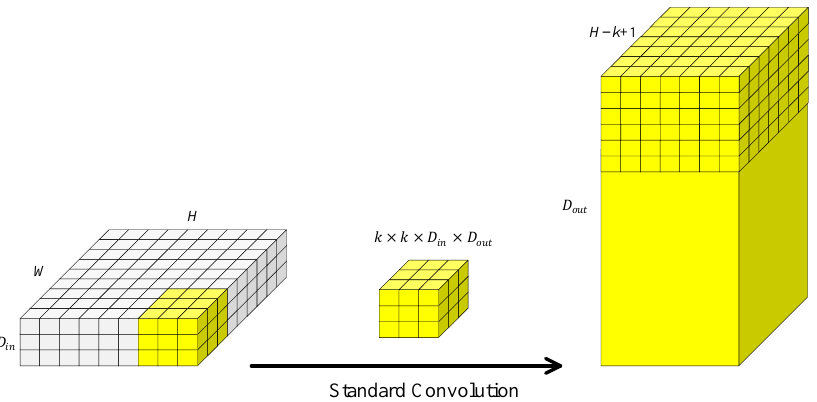
Figure 1. Schematic of standard convolution.